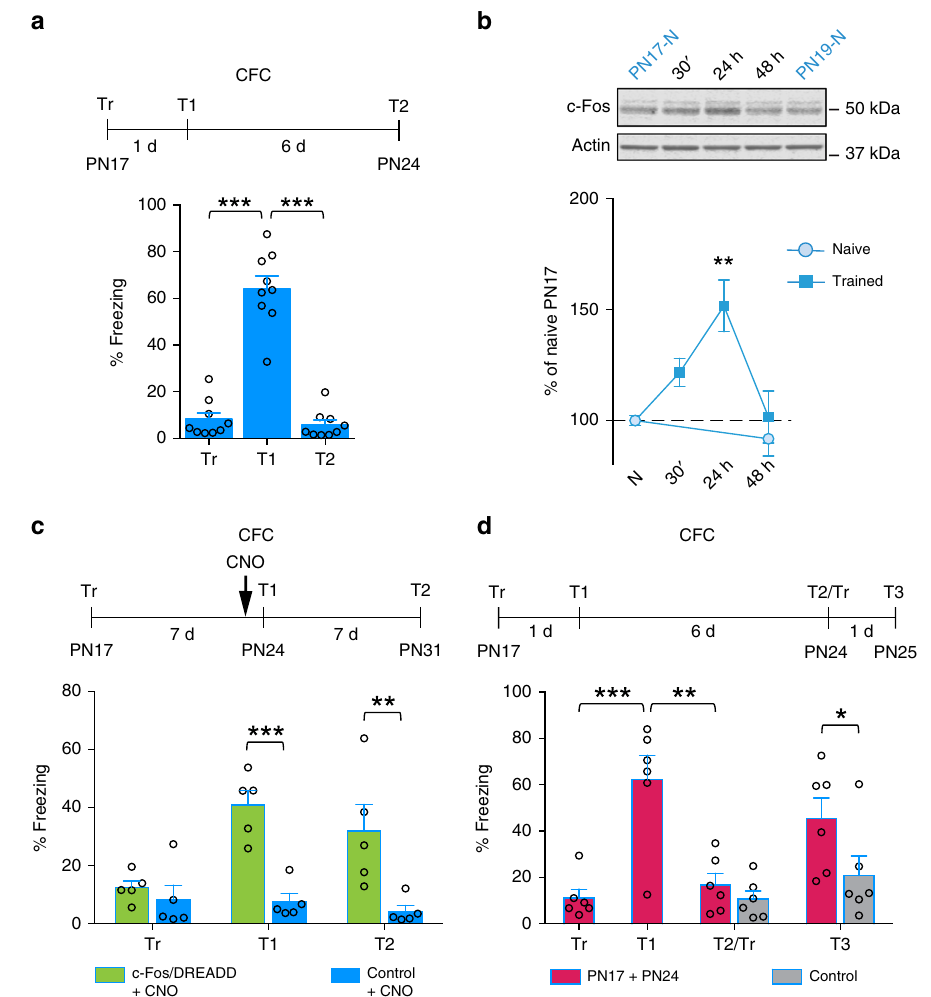
Fig. 7 Chemogenetic reactivation of the cellular networks activated at learning, as well as relearning, matures functional competence. a Mice ( n = 9) were trained in CFC at PN17 and tested 1 day (T1) and 7 days later (T2). *** P < 0.001 (one-way RM ANOVA followed by Tukey ’ s multiple comparisons test). b Densitometry of c-Fos western blot analysis obtained from dHC whole-protein extracts from mice trained in CFC at PN17 and euthanized 30